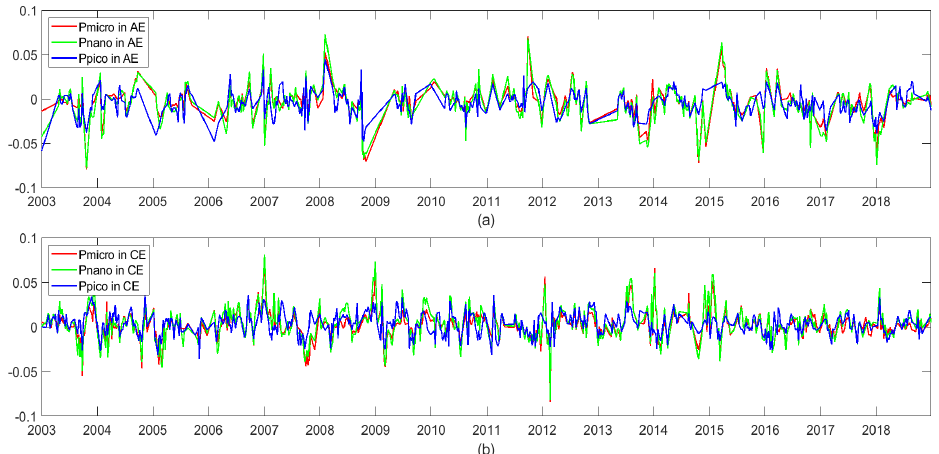
Figure 16. Anomalous time series of phytoplankton of different sizes in the center of anticyclonic eddies (AEs) ( a ) and cyclonic eddies (CEs) ( b ) in the NSCS (unit: mg/m 3 ).